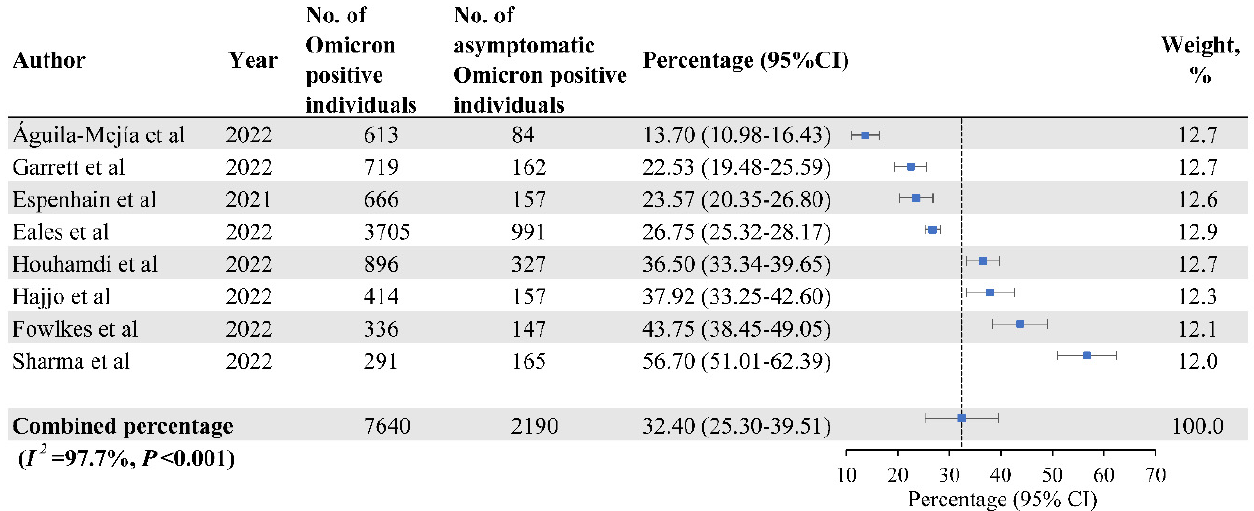
Figure 2. The Percentage of Asymptomatic Infections Among SARS-CoV-2 Omicron Variant-Positive Individuals